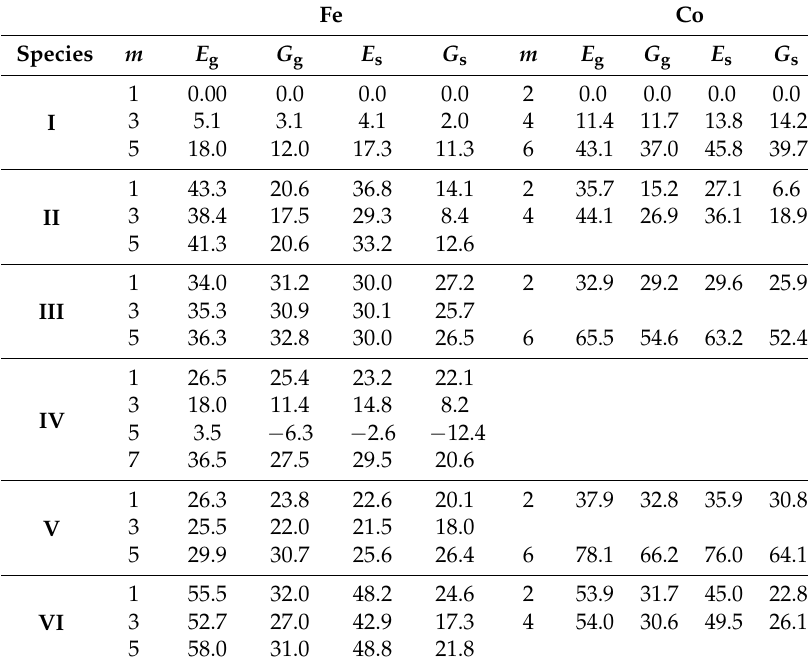
Table 2. Computed stationary points (Gibbs free energies in kcal/mol) for the olefin metathesis reaction pathway for M(SIMes)Cl 2 (=CHPh)PPh 3 (M = Fe and Co) with ethylene as substrate ( m = multiplicity; 1 = singlet; 2 = doublet; 3 = triplet; 4 = quadruplet; 5 = quintuplet; 6 = sextuplet; g = gas; s = solvent) at the BP86-D3BJ/TZVP~sdd level of